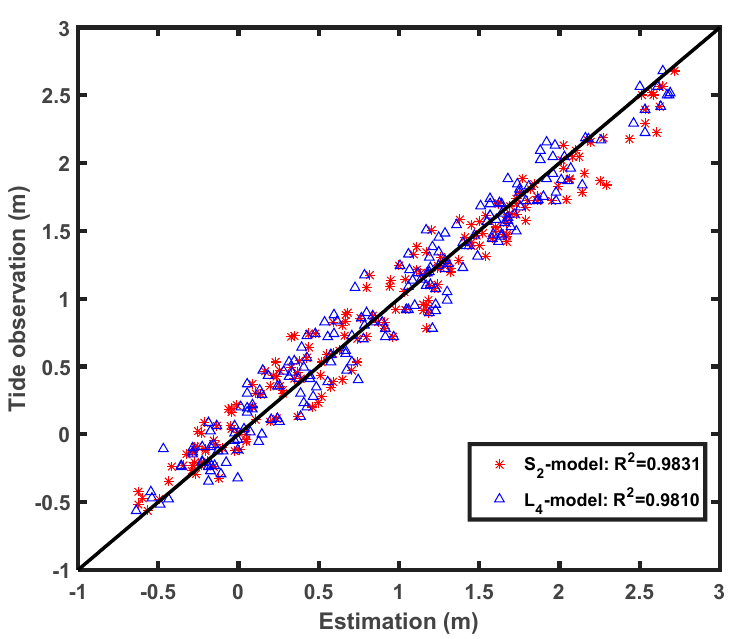
Figure 7. Correlation of GPS dual-frequency phase combination and SNR estimations for the elevation range 5–15° using a linear regression model with tide gauge (TG) observations.